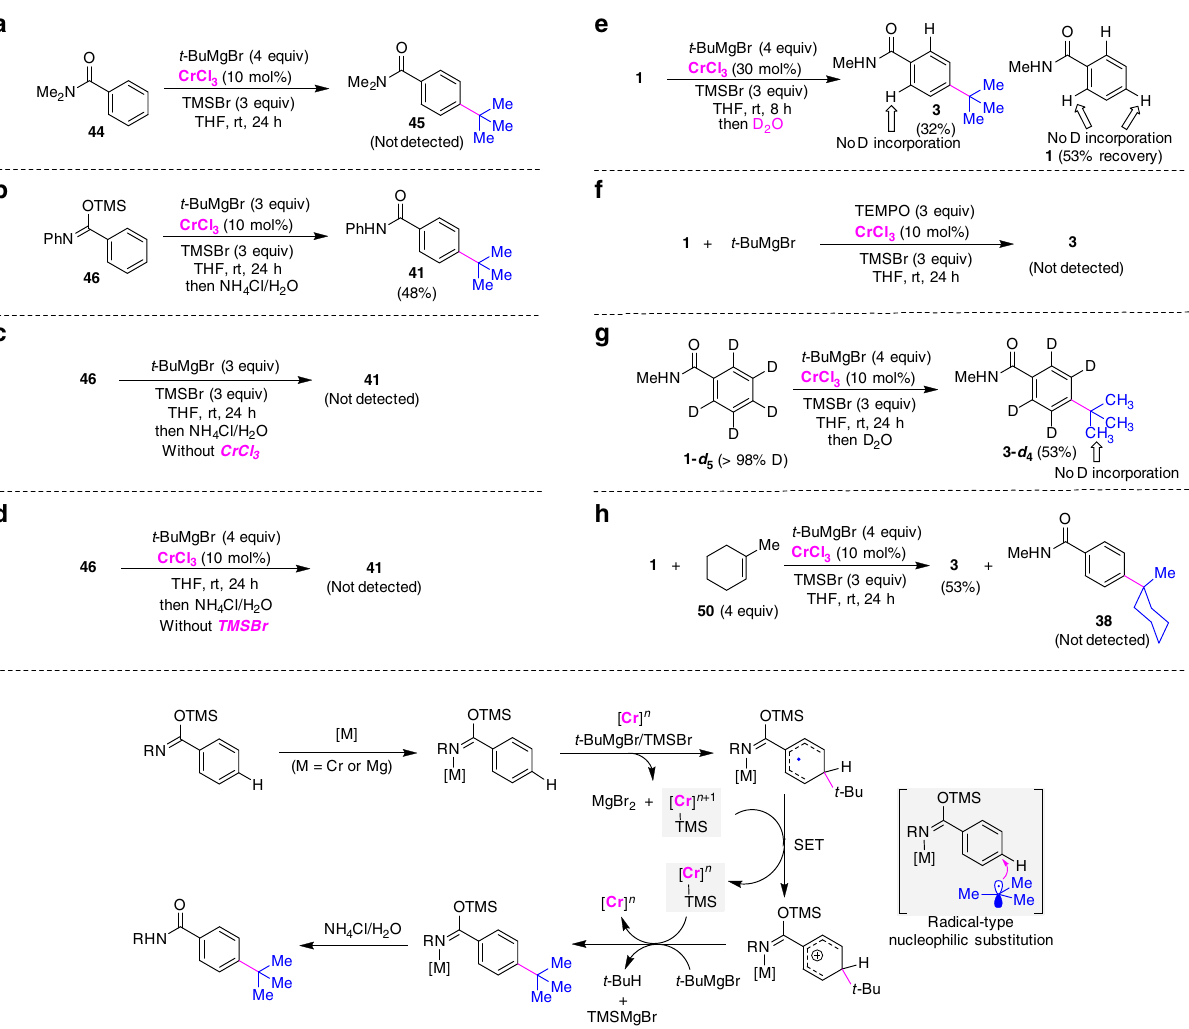
Fig. 5 Preliminary mechanistic studies. a Alkylation with N , N -dimethyl-substituted benzamide. b Alkylation with N -phenylbenzimidate. c Alkylation without CrCl 3 salt. d Alkylation without TMSBr. e Quenching the alkylation using D 2 O. f Scavenger experiment with TEMPO. g Alkylation with deuterated N - methylbenzamide. h Alkylation with 1-methylcyclohex-1-ene. i Plausible reaction